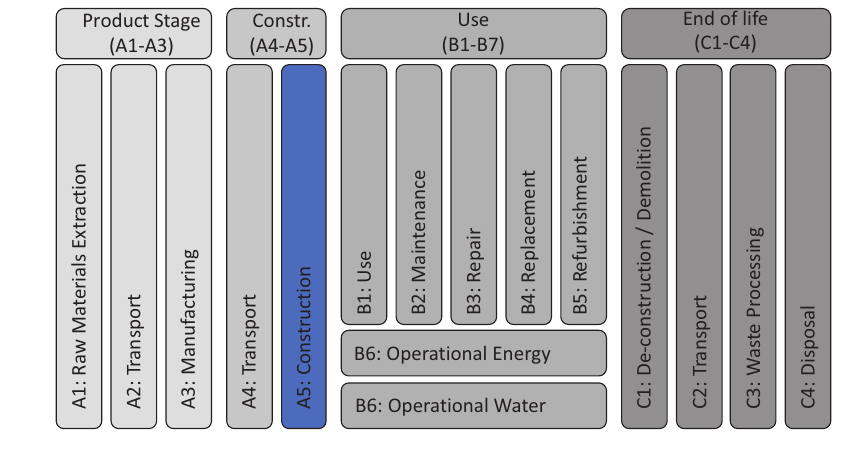
Figure 1. EN15978 System